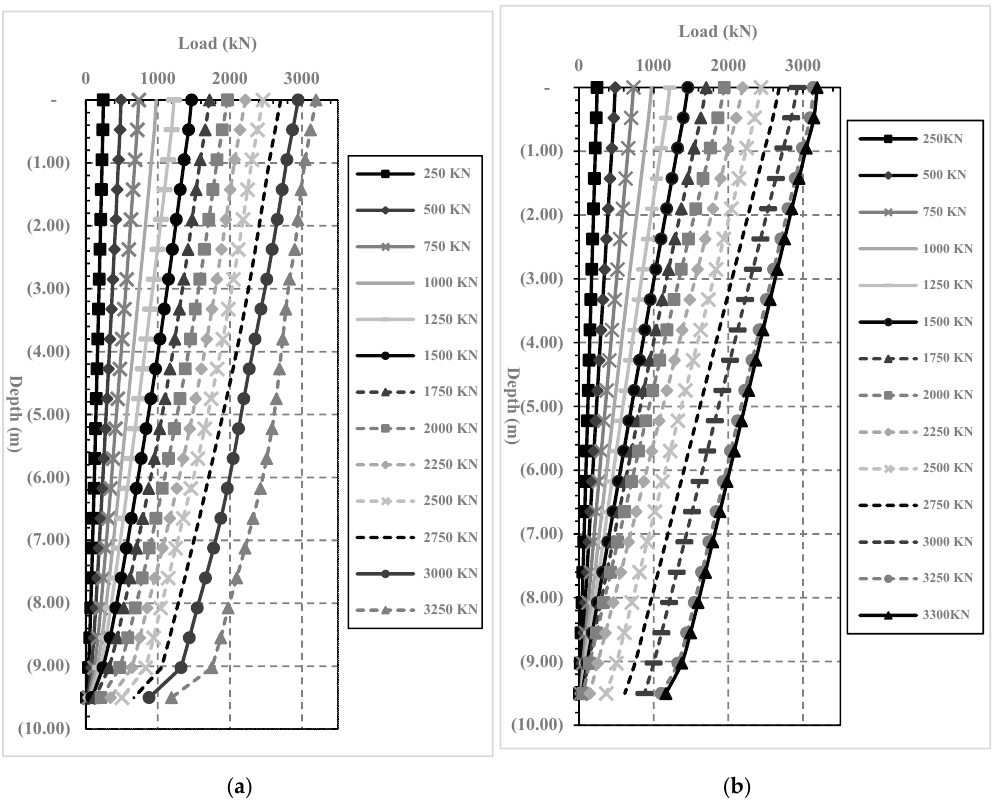
Figure 13. Results of the pile axial load distribution. ( a ) Drained analysis. ( b ) Un-drained analysis. Tangential stresses of the interface elements in the vertical direction (Y-Axis) are obtained from the calibrated numerical models at each load increment along the interface length. The relations between interface tangential stresses and pile length are presented in Figure 14a,b for both drained and undrained analyses, respectively. These tangential stresses represent the distribution of the soil unit skin friction along the pile shaft length at each load increment. In general, skin friction results are consistent with the result of pile load distribution (Figure 13), and indeed the obtained skin friction values are increased with the depth in the drained condition, and also they are constant with the depth in the undrained condition. The pile load transfer behavior presented before in Figures 10 and 11b showed that the full friction mobilization occurred after load increment of 2000 kN in both drained and undrained cases. These results are also consistent with the skin friction results shown in Figure 14a,b. As the obtained shear stress values after this load almost become equal to the soil shear strength (according to MC criterion), which confirmed that full friction mobilization occurred after this load in both drained and undrained conditions.